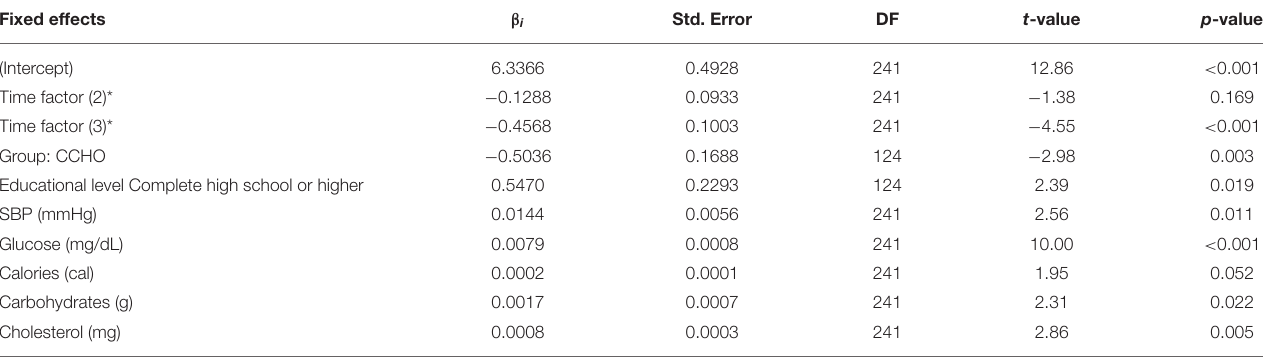
TABLE 2 | Linear mixed multivariate model of intercept and two random